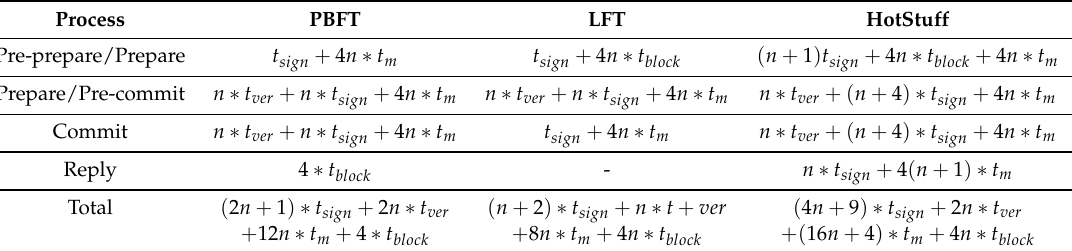
Table 3. Total consensus delay ( n = number of